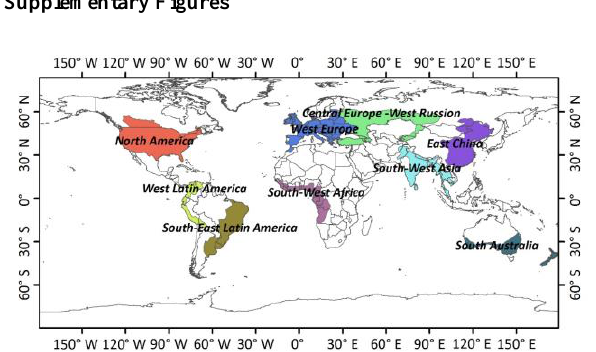
Figure S1. Geographical locations of nine major crop zones, and their corresponding coverage of countries.